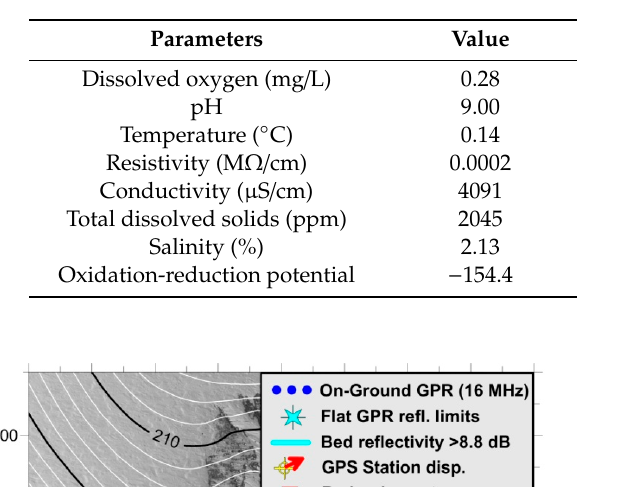
Table 4. Physicochemical parameters of lake-ice blister water determined by a multi-parametric probe (HI 9828).